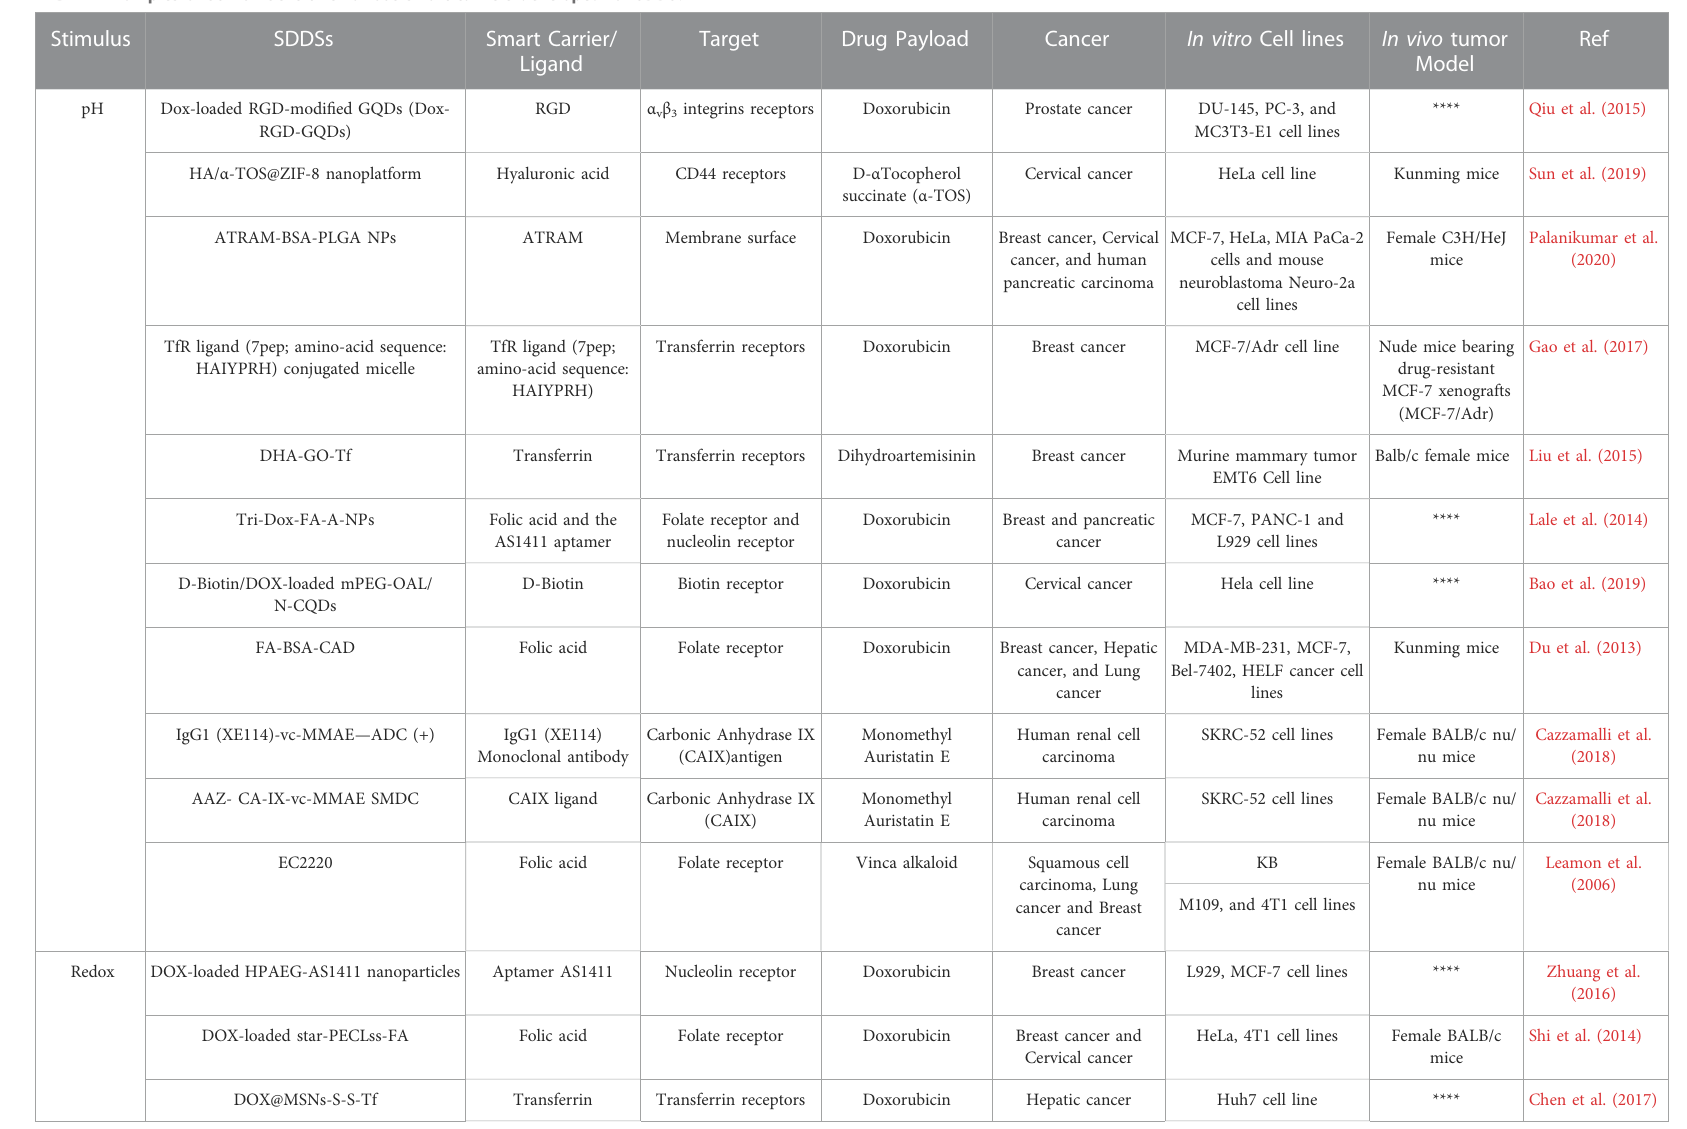
TABLE 1 Examples of Stimuli-Sensitive various smart-carriers developed for